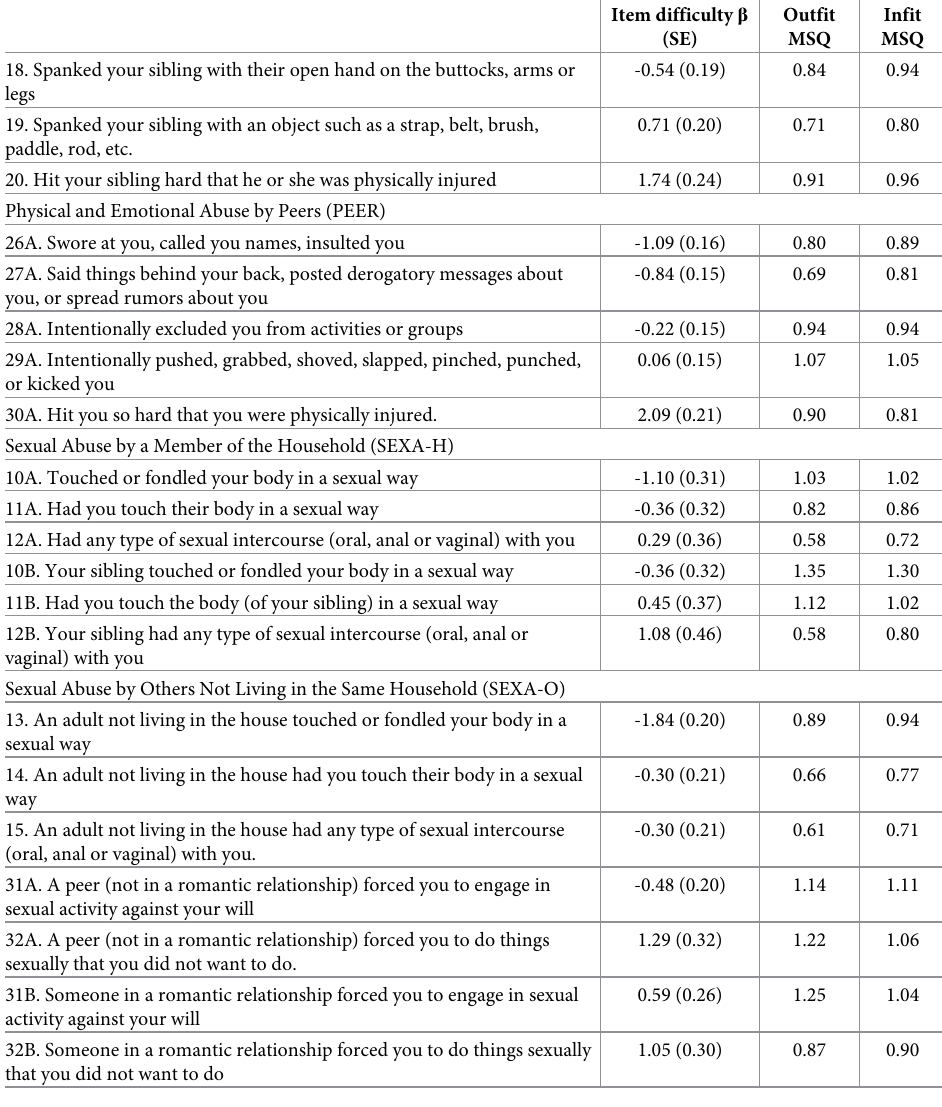
individuals as well as for women and men. The test information curve showed that the test best discriminated high exposure levels with logit scores between 2 and 4, including 40.02% of the information. In the target range (i.e., logit score between 0 and 2), this scale had 30.76% of the total information. Subscale 4 . Emotional Neglect (EN) . Four items were included (i.e., item 33, 34, 39, 40). Item 39 and item 40 were recoded prior to the inclusion in the subscale. None of the items showed a misfit to the scale and both Andersen tests were not significant, Χ 2 (3) = 4.56, p = .207 (median of age as the split criterion) and Χ 2 (3) = 6.11, p = .106 (sex as the split criterion). The test infor- mation function had the highest information of the scale within the target range between